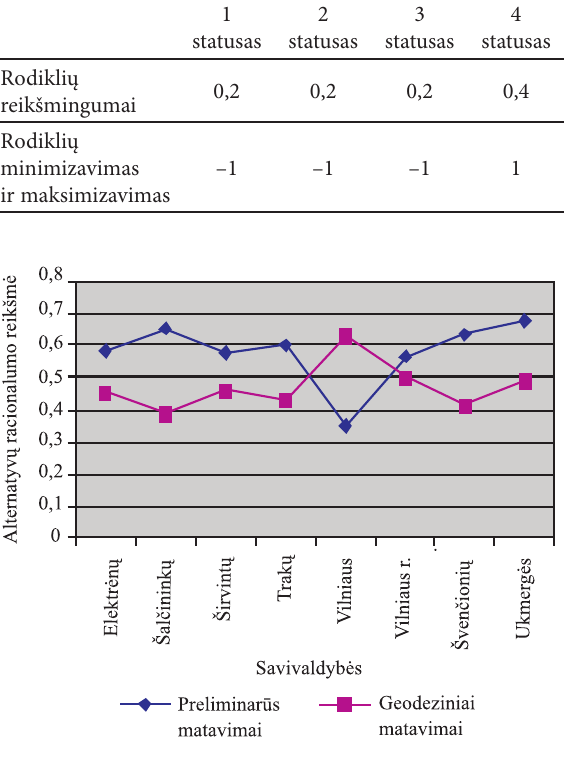
Fig. 1. The walternative rationality results of the land parcels in Vilnius municipality using tentative and geodesic measurements žemės sklypų ribas tikslinti pagal didesnio tikslumo kar- tografinę medžiagą (Nekilnojamojo daikto ... 2006), o tai negalima atlikti naudojant geodezinių matavimų